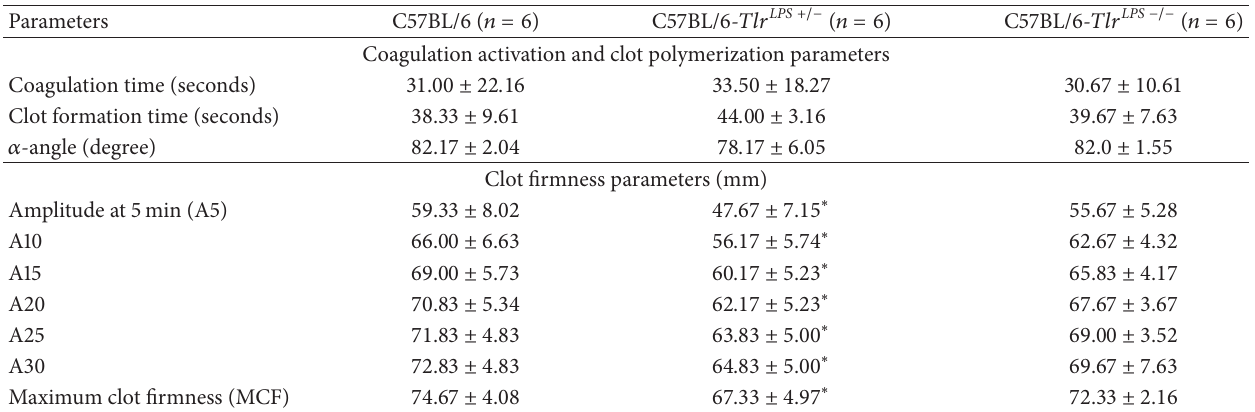
Table 6: ROTEM measurements of EXTEM in experimental mice.